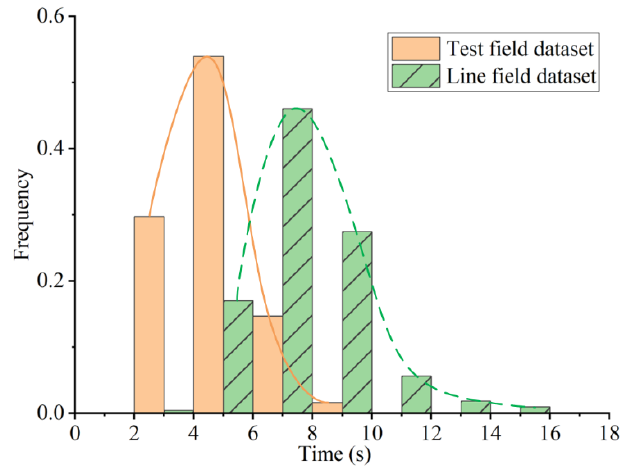
Figure 25. The time-costs of each group of synthetic data.